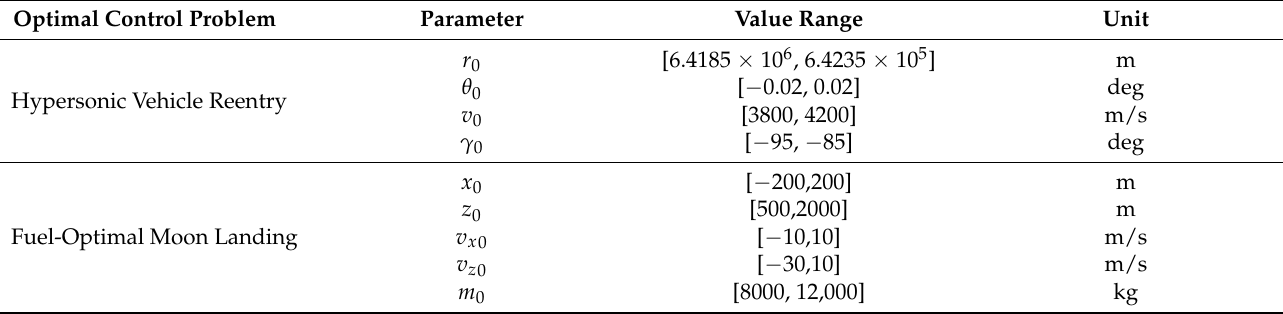
Table 4. The initial state spaces of the